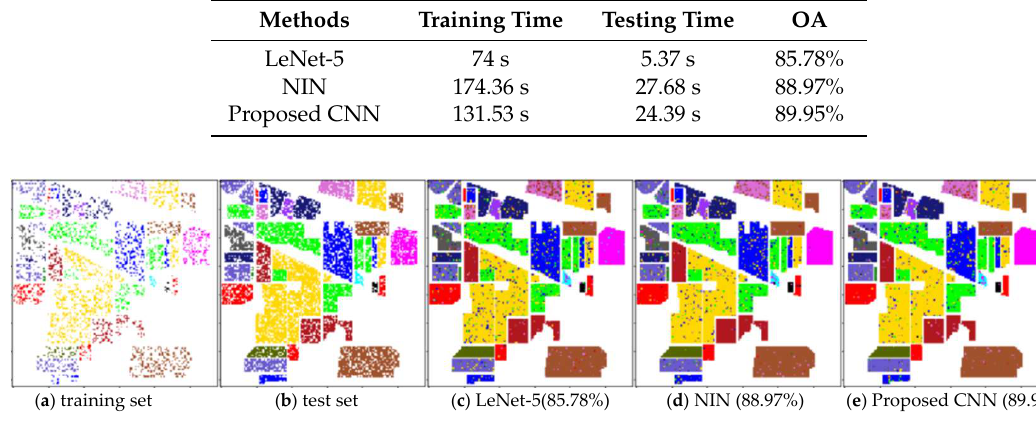
Table 10. Computing consumption of different CNN architectures on the Indian Pines dataset.